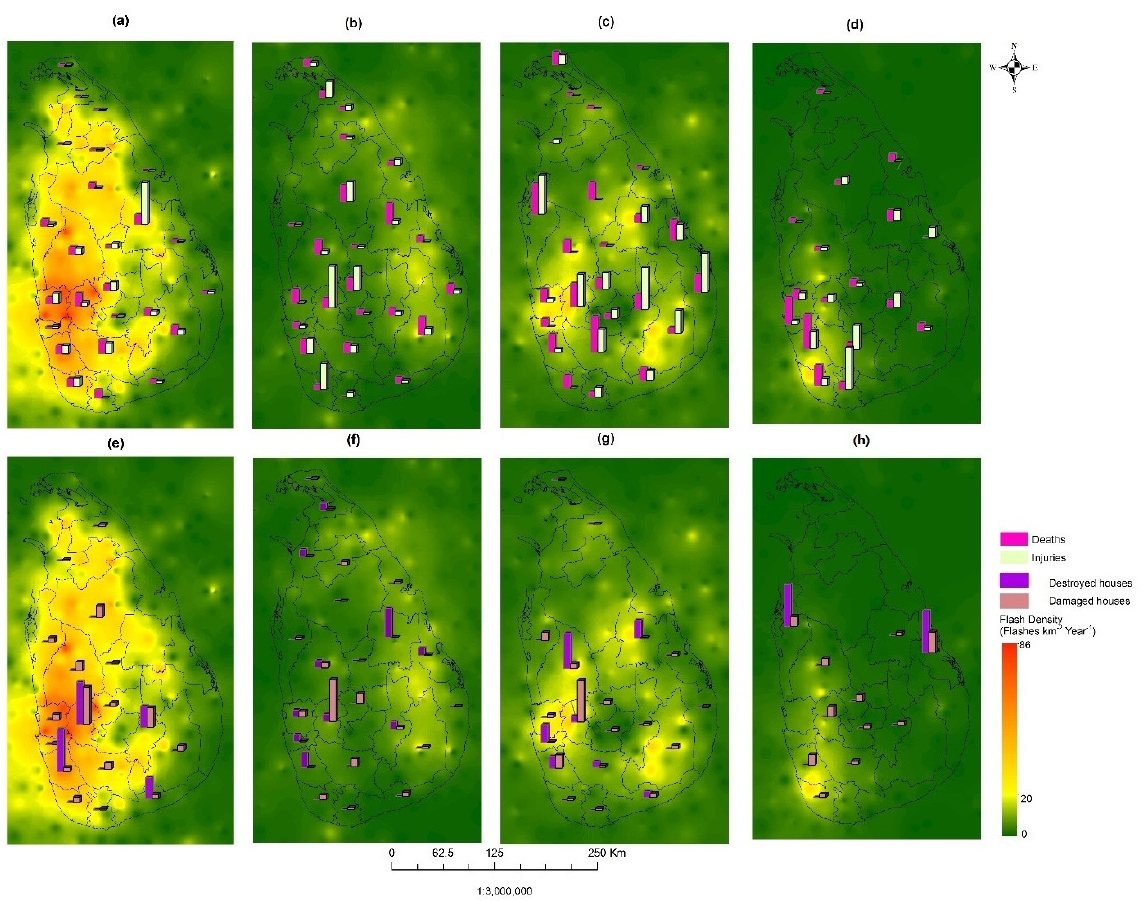
Figure 11. Variation of the lightning flash density with the recorded lightning accidents (in %) in Sri Lanka, from 1974 to 2019, for all four climate seasons, presented district-wise: ( a ) FIM deaths and injuries, ( b ) SWM deaths and injuries, ( c ) SIM deaths and injuries, ( d ) NEM deaths and injuries, ( e ) FIM destroyed and damaged houses, ( f ) SWM destroyed and damaged houses, ( g ) SIM destroyed and damaged houses, and ( h ) NEM destroyed and damaged